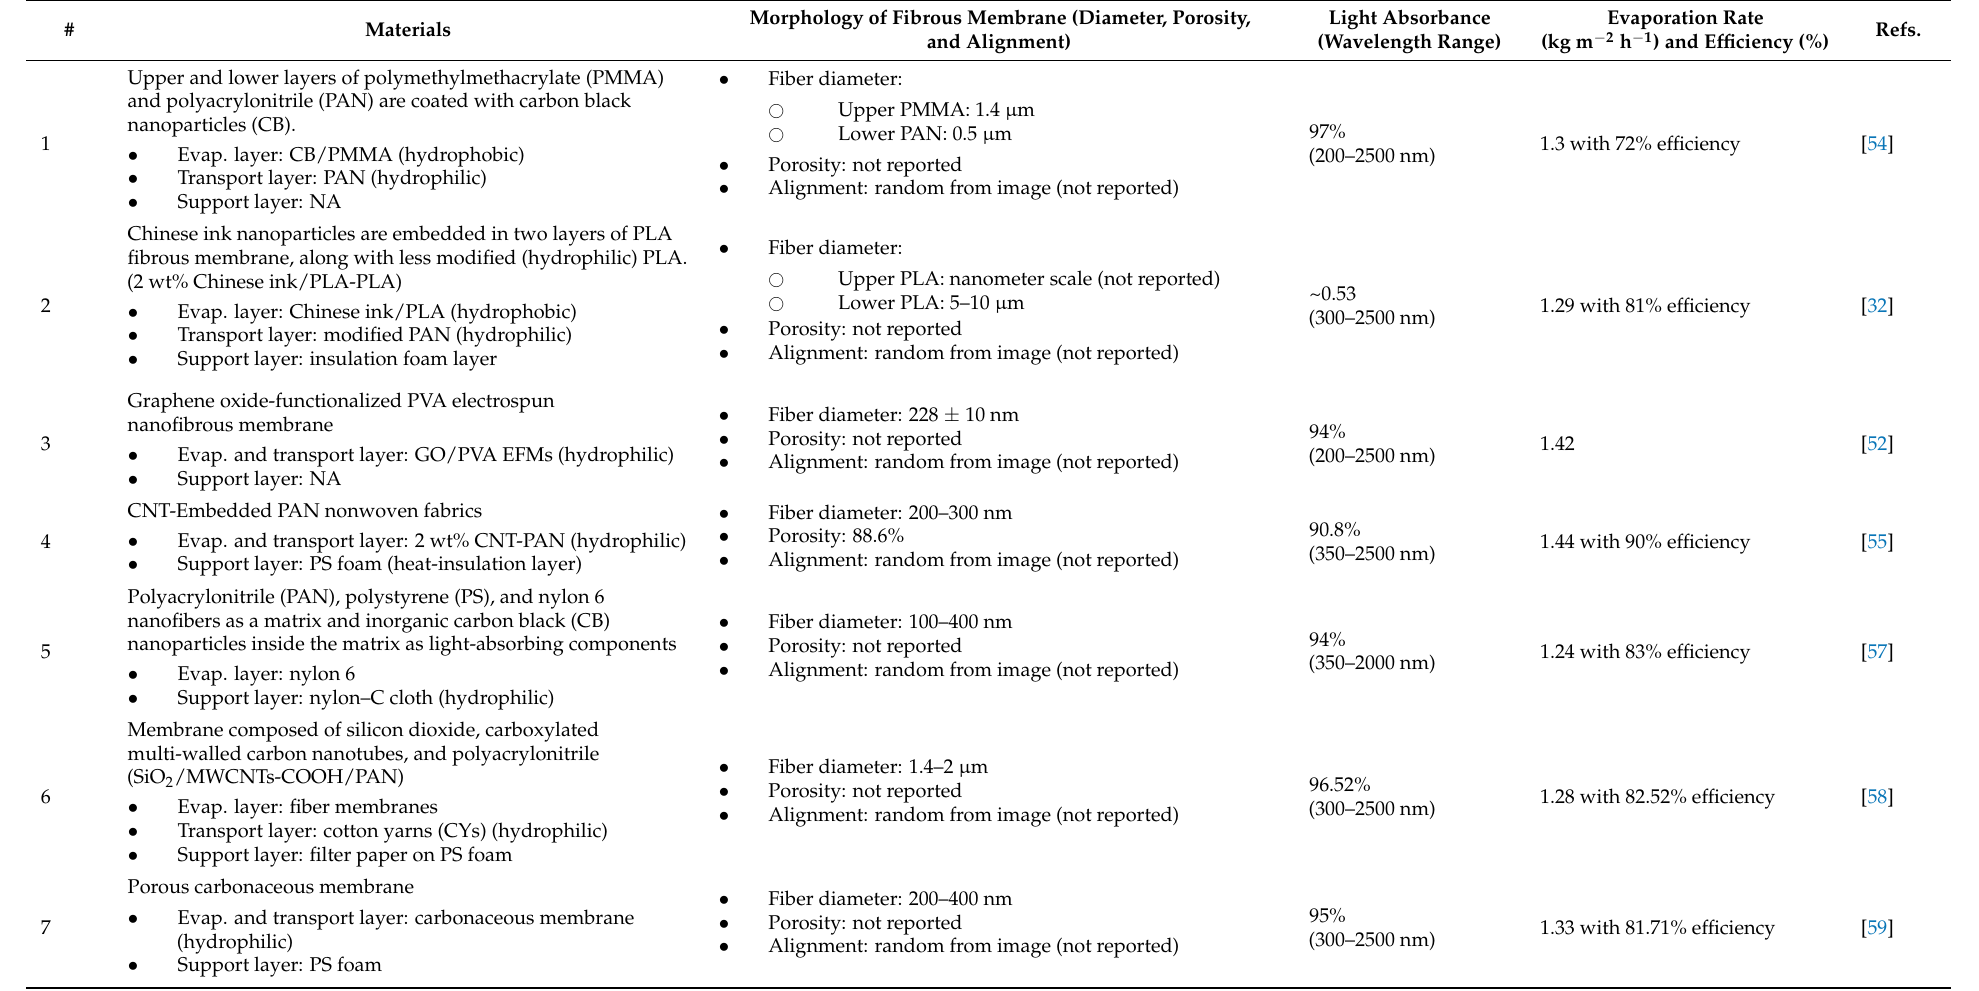
Table 3. List of various functional polymer electrospun nanofibrous membranes used in SDIE applications. # Materials